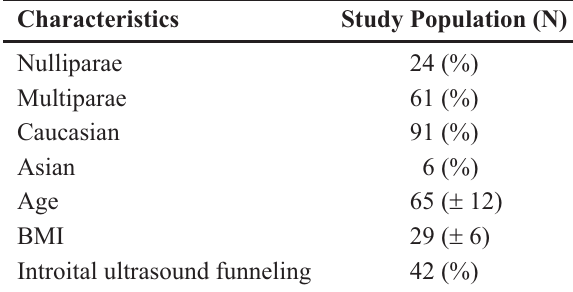
Table 1 – Characteristics of the study